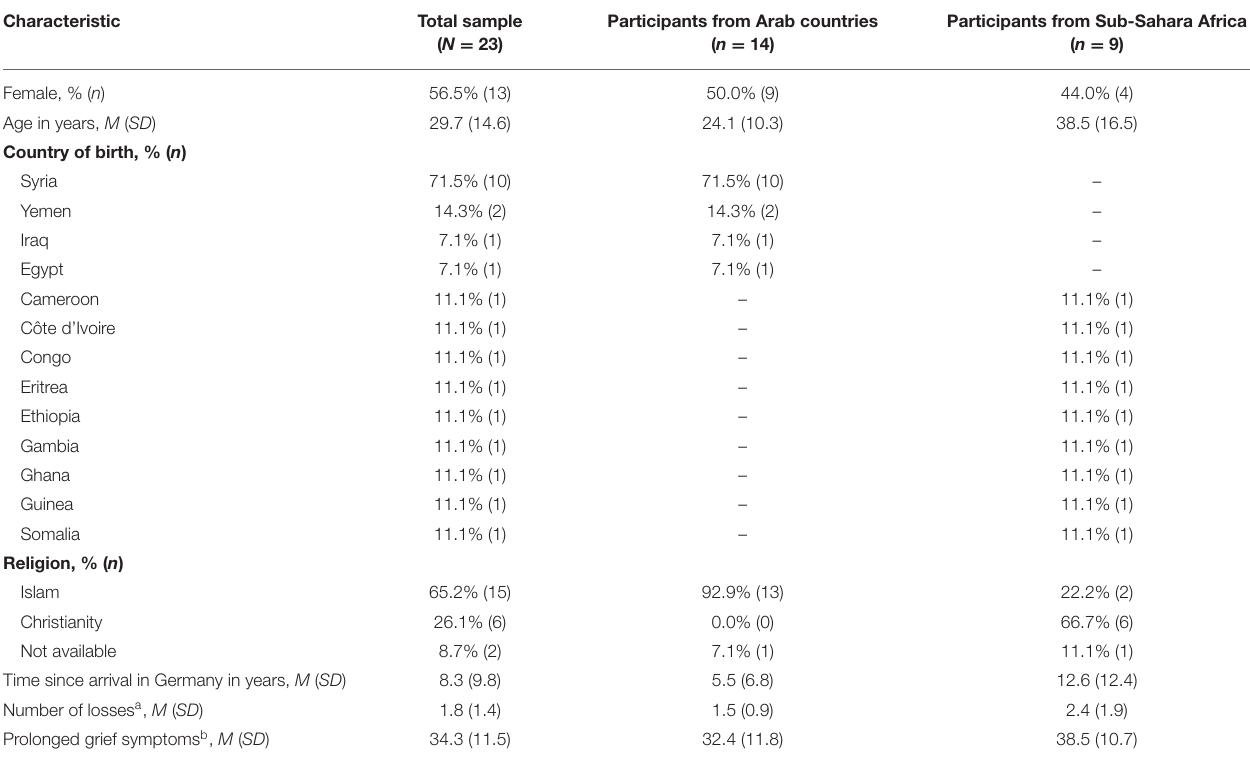
TABLE 1 | Sociodemographic, migration-, and loss-related characteristics.